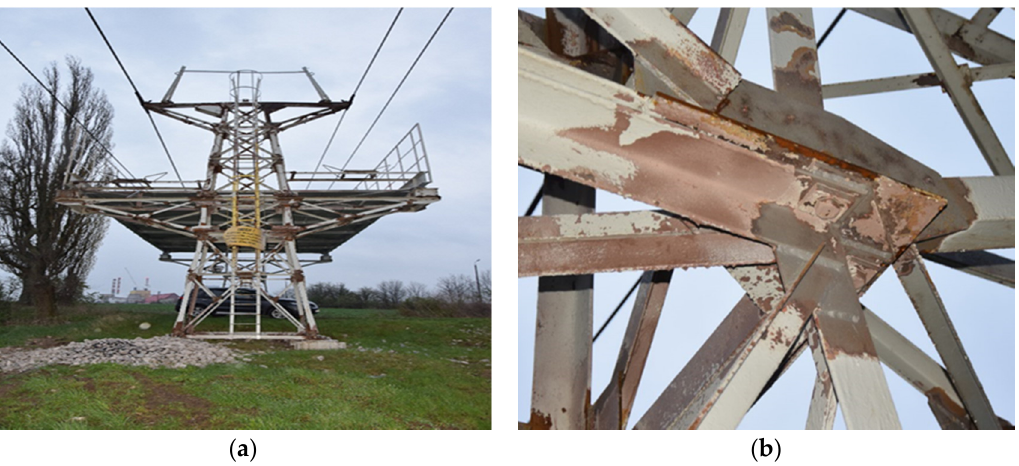
Figure 4. ( a ) Side view of column 2. ( b ) External view of the upper chord; signs of surface corrosion on truss members.